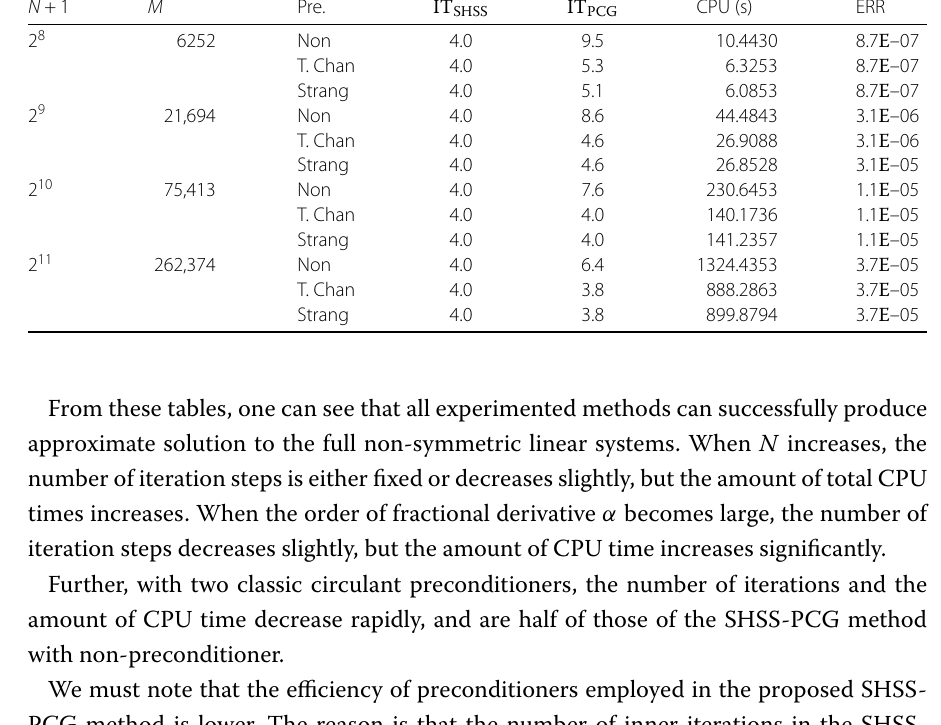
Table 3 Numerical results of the SHSS-PCG method for solving FDE ( α = 1.8) N + 1 M Pre. IT SHSS IT